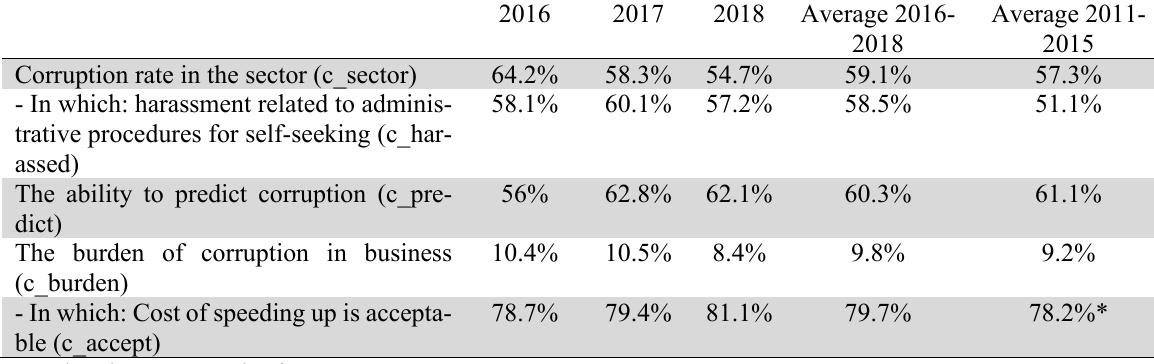
Measurement of corruption variables over